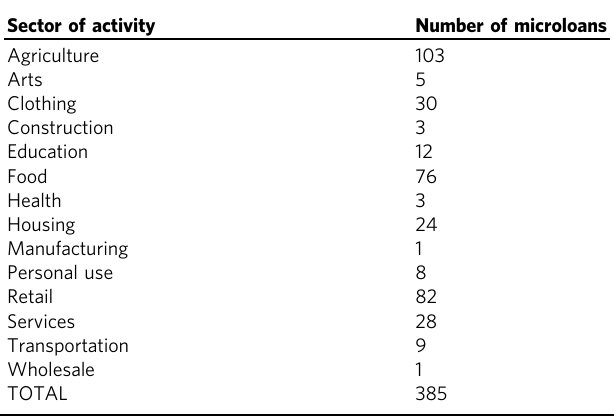
Table 3 Number of microloans in different sectors. Source: Own elaboration.